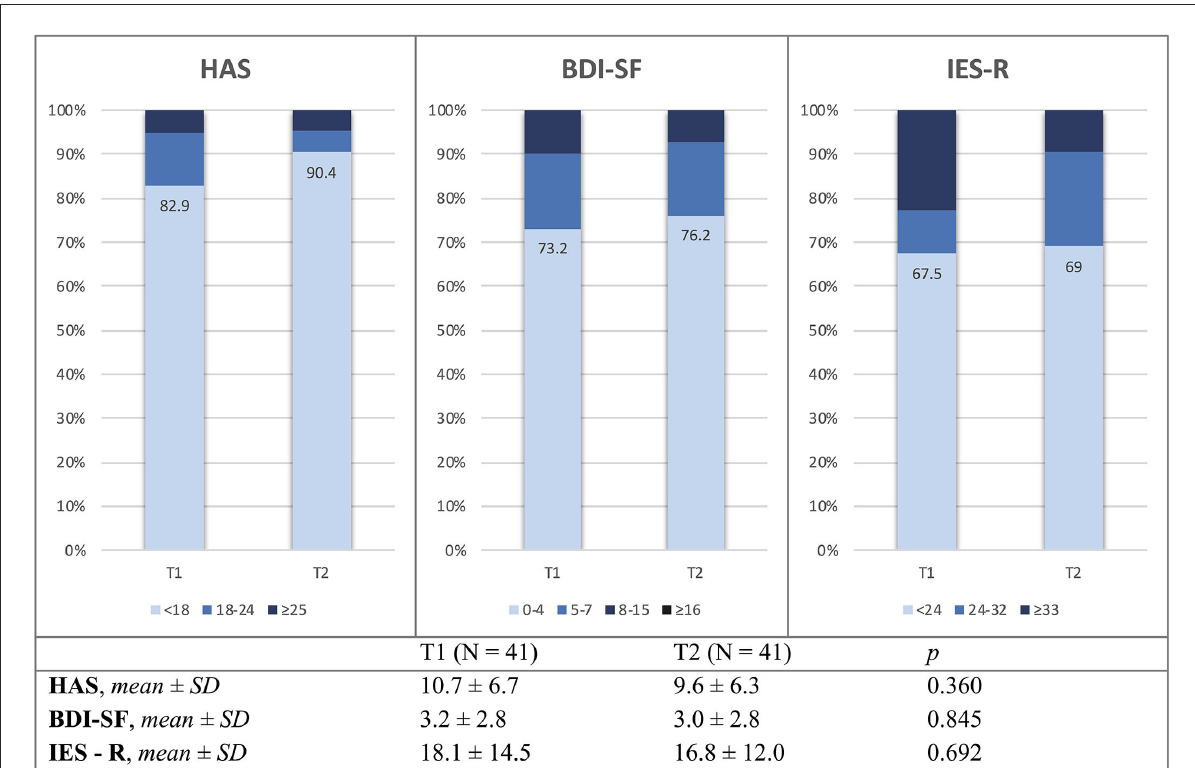
FIGURE2 Mean values and distribution of HAS, BDI-SF, and IES-R scores at T1 and T2 study visits. HAS, Hamilton anxiety rating scale; BDI-SF, Beck depression inventory – short form; IES-R, impact of event scale – revised; n, number of patients; SD, standard deviation; T1, 2-month study visit; T2, 10-month study